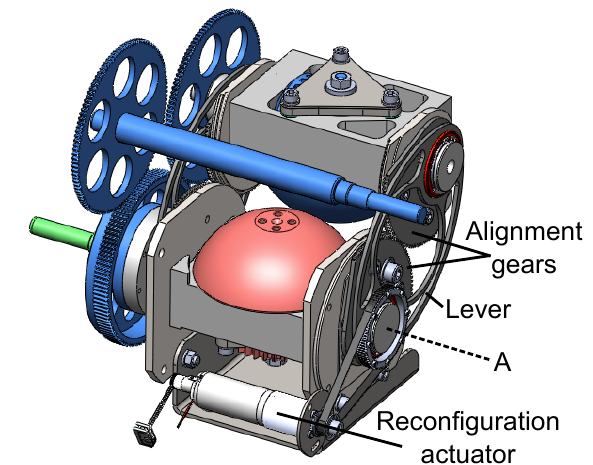
Figure 10. An image showing the drive train and reconfiguration mechanism of the dual-hemi CVT. By using the “reconfiguration actuator”, the “lever” is rotated around point “A” with a timing belt. The “lever” has a length of twice the radius of the hemispheres. Referring to Figure 1a, it corresponds to the dash-dotted line between the centers of the red hemisphere and the blue sphere. The “alignment gears” have a pitch radius that is equal to the radius of the spheres and are an extra measure to make the blue hemisphere roll neatly over the red hemisphere when the “lever” is adjusted. In order to reduce the required work for the reconfiguration mechanism, a spring-based gravity compensator (not shown in the figure) is added to compensate for the gravitational forces acting on the reconfiguration mechanism.